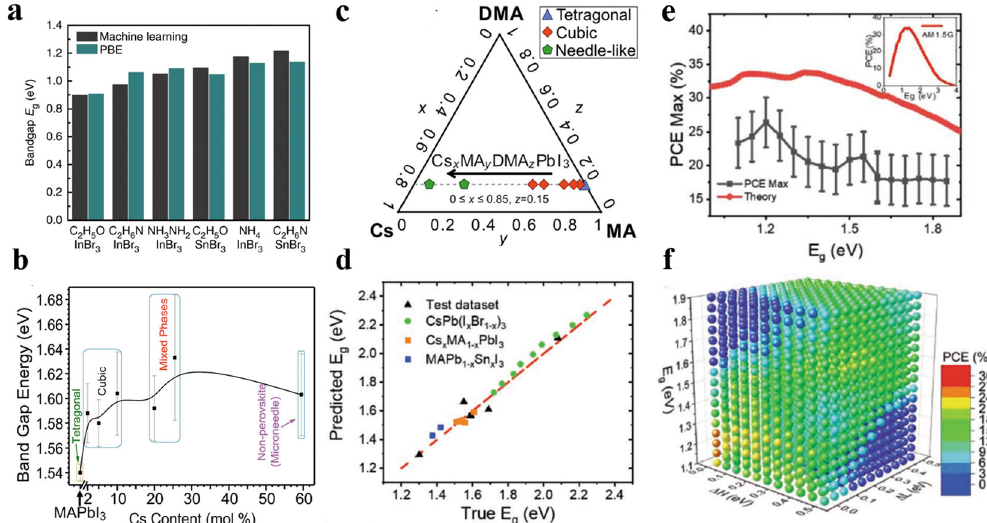
Fig. 7 Applications of ML in HOIPs. a A comparison of ML-predicted with DFT-calculated data of six HOIPs 116 . b The E g energy changes with Cs (mol %) in Cs x MA 0.85-x DMA 0.15 PbI 3 and the cubic structure begins to recover when x = 0.02 118 . c Ternary diagram denoting the different- stoichiometry crystal structures 118 . d The correlation of the ML E g data and the experimental E g data. Reproduced with permission from ref. 121 . Copyright John Wiley and Sons, Inc. 2019 e Blackline: the maximum PCE predicted by ML corresponding to each E g (1.2 – 1.3 eV); redline: the PCE of Shockley – Queisser limit. Reproduced with permission from ref. 121 . Copyright John Wiley and Sons, Inc. 2019 f 4D-plot of PCE with respect to E g , Δ H , and Δ L , indicating the highest PCE values with the bandgap in the range of 1.2 – 1.3 eV. Reproduced with permission from ref. 121 . Copyright John Wiley and Sons, Inc.